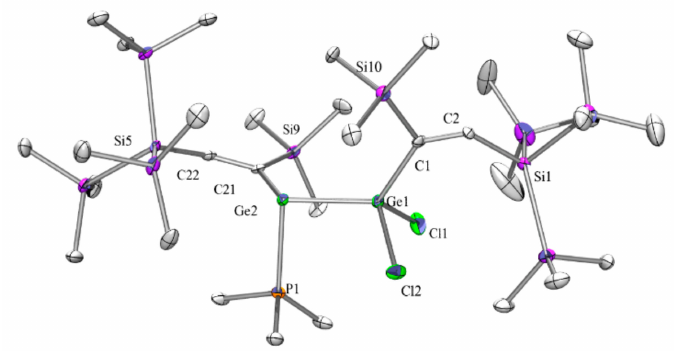
Figure 4. Molecular structure of 7 (thermal ellipsoid plot drawn at the 30% probability level). All hydrogen atoms omitted for clarity (bond lengths in Å, angles in deg). Ge(1)–C(1) 1.981(9),